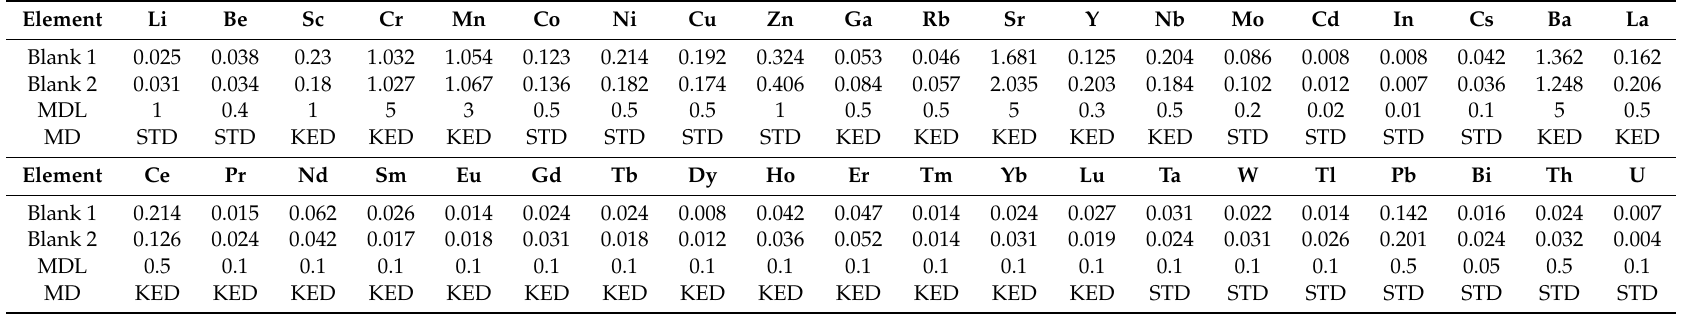
Table 1. Concentrations of the trace elements of duplicate blank samples (ug / g), method detection limits (MDL, ug / g), and measurement modes (MD) for the ICP-MS analysis in the present